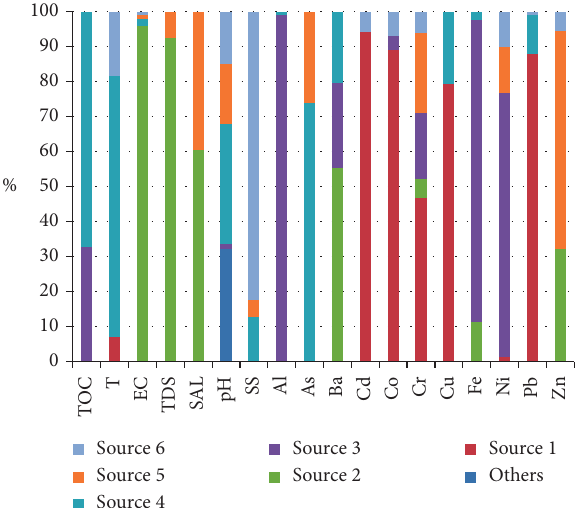
Figure 2: Concentration % for water quality parameters in winter.